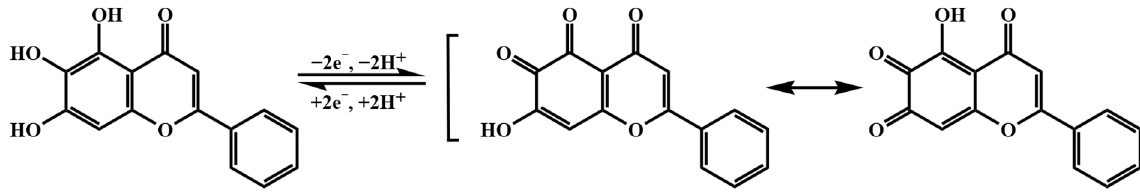
Figure 7. ( A ) CVs of 10.0 µM baicalein on TiO 2 -MXene/PEDOT:PSS/GCE in 0.1 M PB (pH 2.0) at di ff erent scan rates ( v ) from 25 to 300 mV·s − 1 ; ( B ) The relationship between I p and v ; ( C ) The relation- ship between E p and ln v .